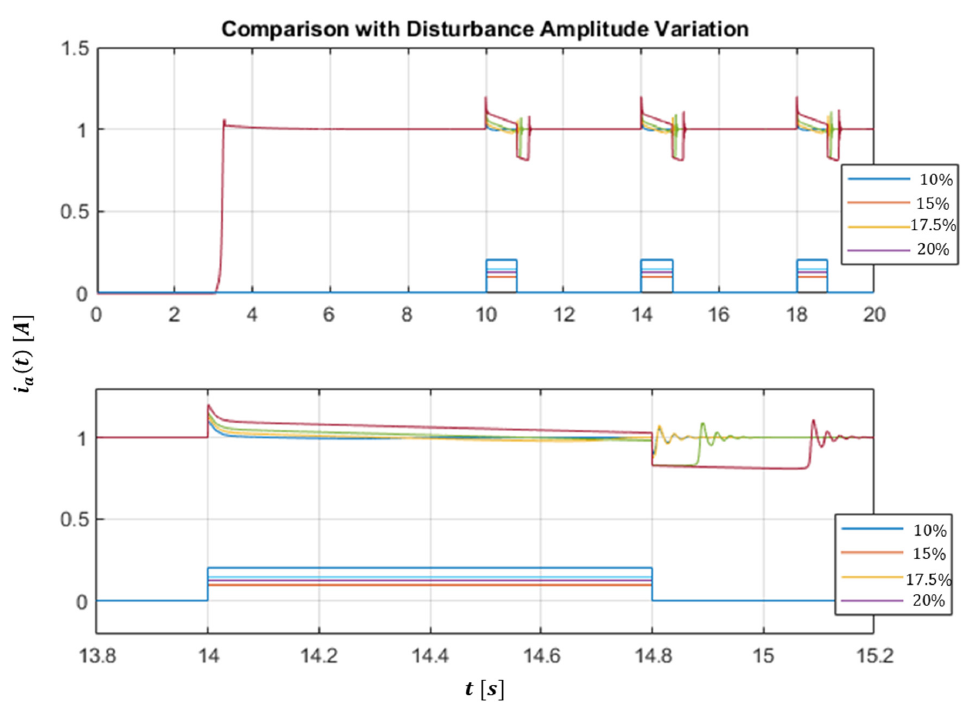
Figure 10. Disturbance Rejection with different disturbance signal amplitude.